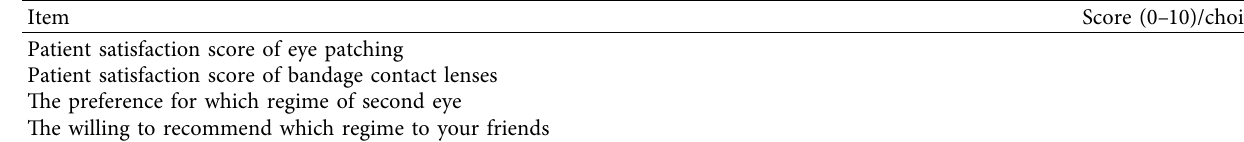
Table 1: Satisfaction questionnaire of postoperative cataract